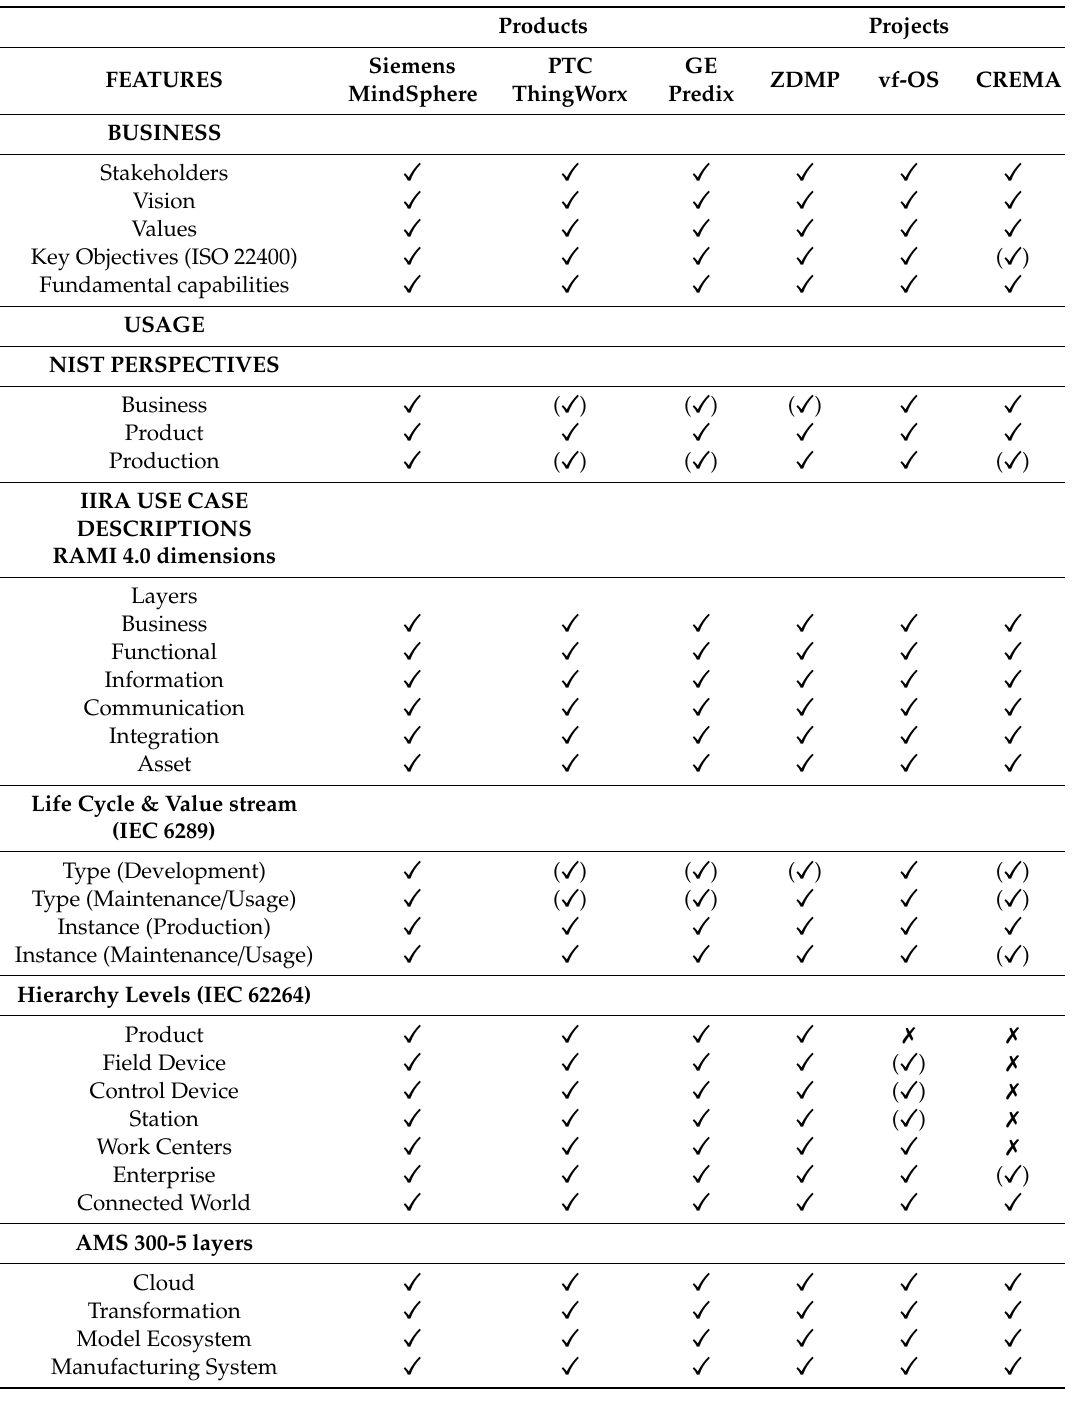
Table 1. Reference Model